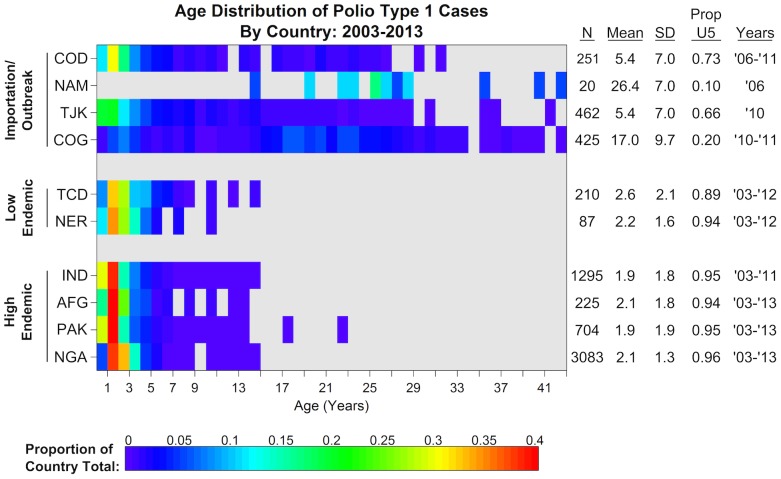
Distribution of cases by age (in years) during previous polio outbreaks for endemic and previously polio-free countries.The number of confirmed type 1 cases, mean age of infection, standard deviation of infection age, proportion of cases under five years old, and duration of case data used are in the table to right. High endemic countries are those that have sustained continuous transmission: India (IND), Afghanistan (AFG), Pakistan (PAK), and Nigeria (NGA). Low endemic areas are those that are exposed periodically to virus due to regular importations: Chad (TCD) and Niger (NER). Importation countries are those that have not reported WPV transmission since at least 2000: Democratic Republic of Congo (COD), Namibia (NAM), Tajikistan (TJK), and Republic of Congo (COG). Information compiled from multiple AFP databases maintained by WHO HQ, regional and country offices.